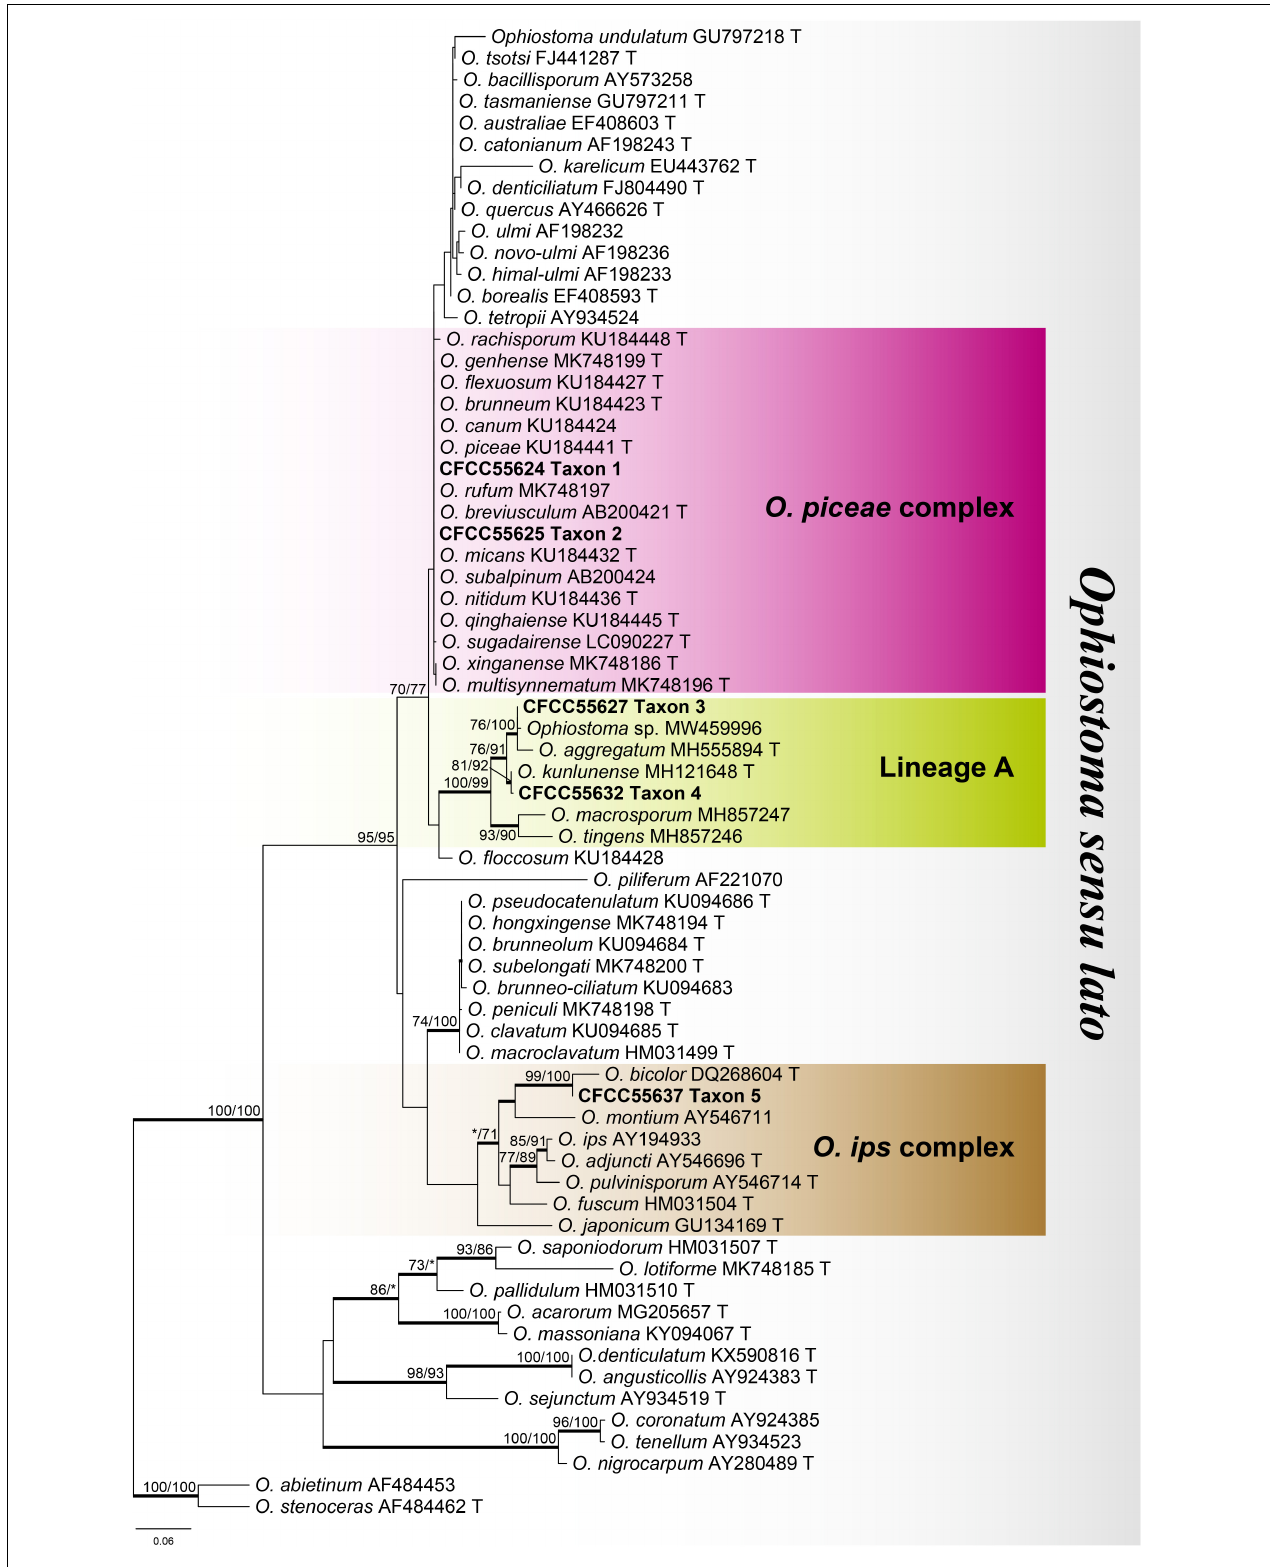
FIGURE 2 | Phylogram of Ophiostoma sensu lato based on ITS sequence data. Bold branches indicate posterior probability values ≥ 0.9. The MP/ML bootstrap support values ≥ 70% are recorded at the nodes. T, ex-type isolates.